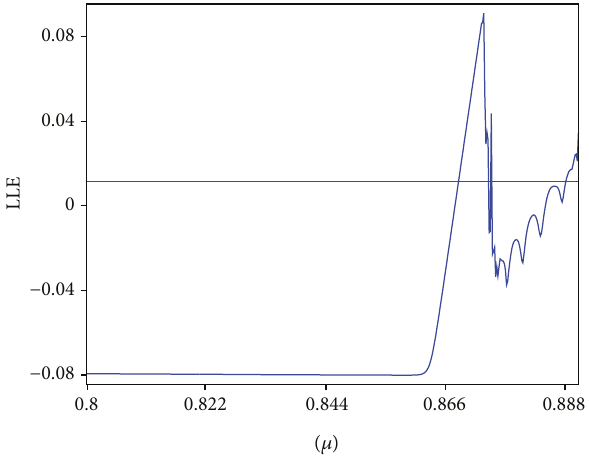
Figure 17: The largest Lyapunov exponent of the system with respect to η ∈ 0, 3 80 . Figure 15: The largest Lyapunov exponent of the system with